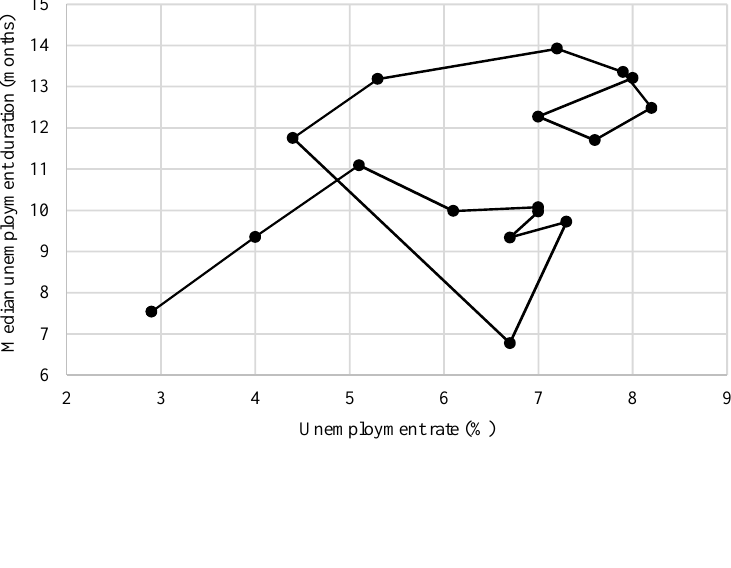
Figure 5. Relation between the unemployment rate and the median